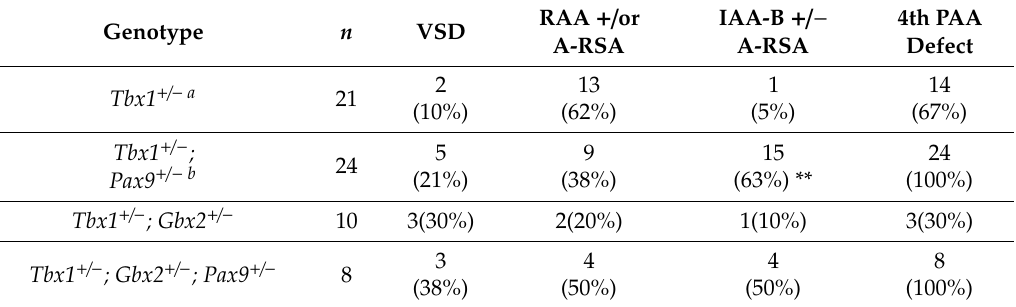
Table 3. Number of cardiovascular defects observed in Tbx1;Gbx2;Pax9 mutant